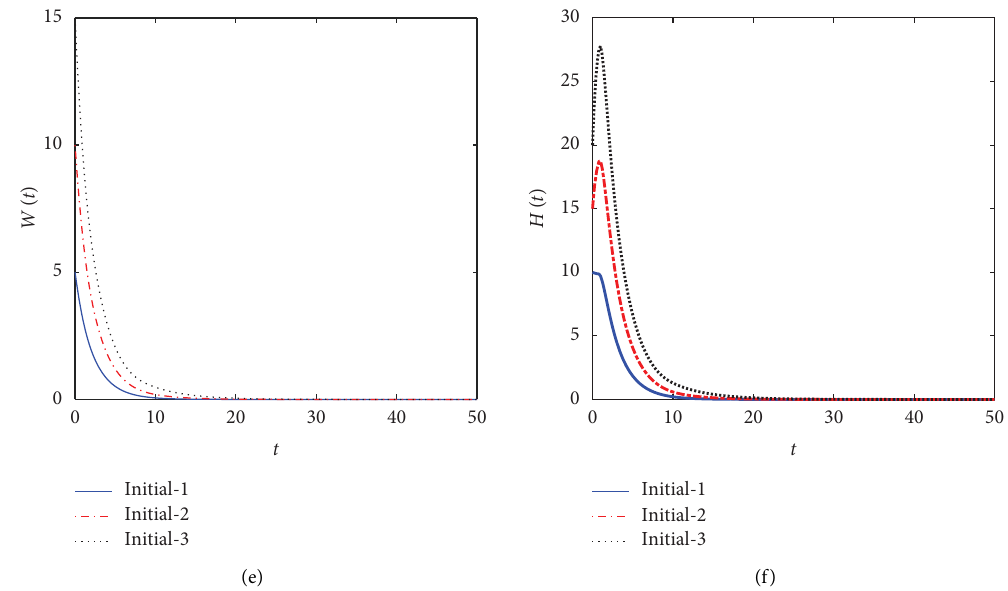
Figure 4: Te numerical simulations of model (64) for η � 2 . 9, υ � 0 . 002, ℘ � 0 . 1, and I � 0 . 0001 using three diferent initial conditions sets. SARS-CoV-2 monoinfection equilibrium EP V � ( 0 . 4285 , 0 . 0087 , 0 . 018 , 1094 . 69 , 0 , 0 ) is G.A.S. (a) Uninfected epithelial cells. (b) Infected epithelial cell. (c) SARS-CoV-2. (d) Uninfected CD4 + T cells. (e) Infected CD4 + T cells. (f) HIV-1.